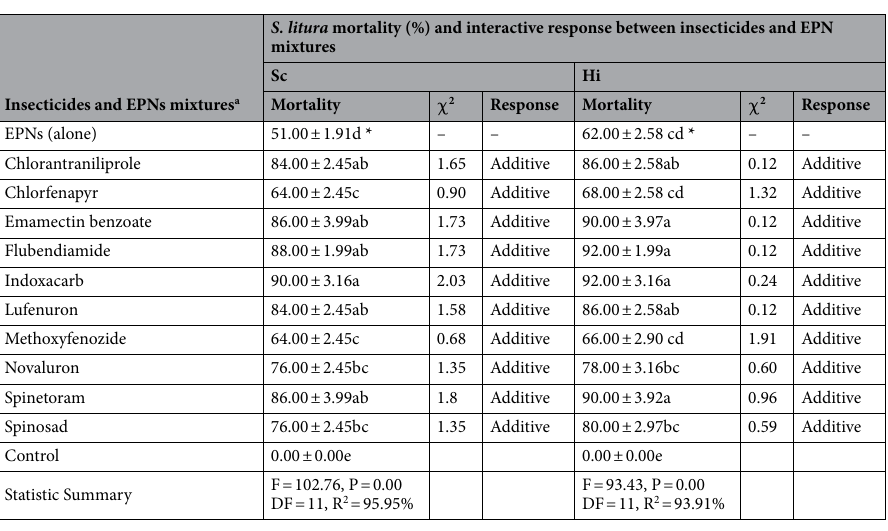
Table 5. Toxicity of selected insecticides and nematode mixtures against S. litura after 96 h of treatment application. Sc S. carpocapsae , Hi H. indica. * Means followed by the same letter within a column do not differ significantly at 5% probability. a Median lethal concentrations (LC 50 ) of insecticides and 500 IJs of each EPN specie were applied in each treatment